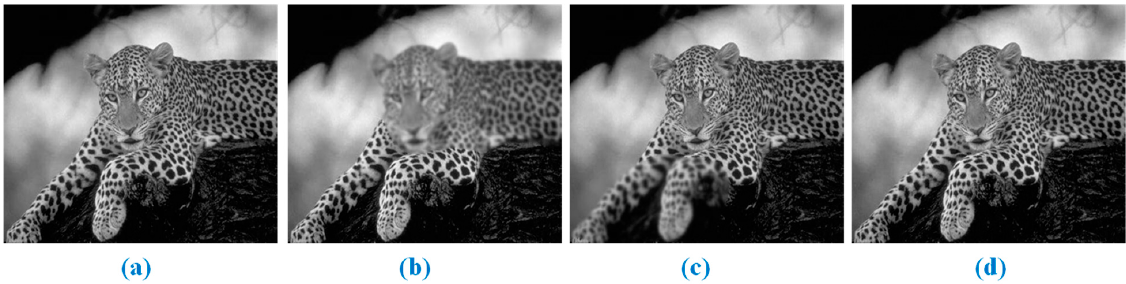
Figure 5. (Leopard): ( a ) Original Image; ( b , c ) Multi-focus input images; ( d ) Proposed fusion.